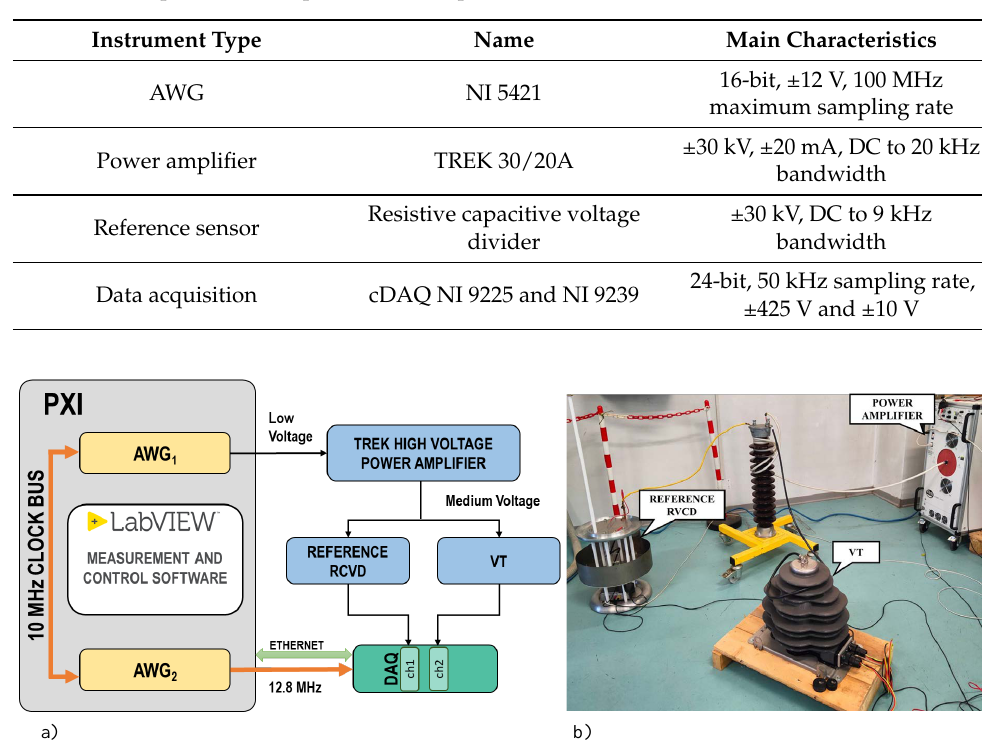
Table 1. Description of the experimental setup instrumentation.